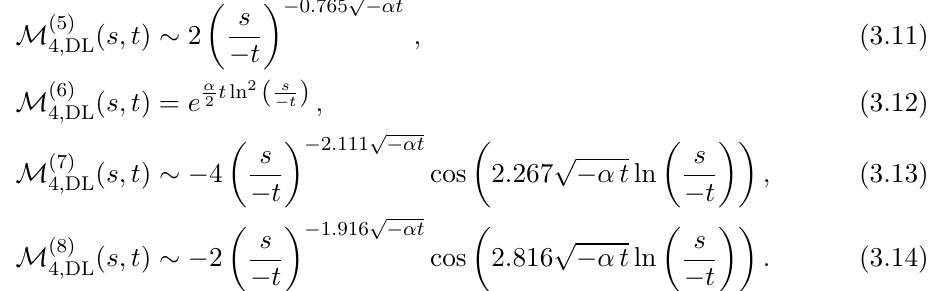
Figure 7 . The 20 zeroes on the complex plane z = x + iy for H (cid:0) 1 line with argument equal to 3 (cid:25) (cid:12)gure 6 and (cid:12)gure